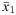
Triangular diagram classifying communities at the second level by their relationship with the walnut structure.Each community is depicted by a circle located at point (x, y) inside the equilateral triangle, which corresponds to the composition (x1, x2, and x3) of firms belonging to the IN, OUT, and GSCC components that are represented in three-dimensional space; the one-to-one correspondence between (x, y) and (x1, x2, x3) is illustrated in the associated figure (a). The size of the communities is reflected by the area of their associated circles. The triangular region is decomposed into six domains with the average composition (x¯1, x¯2, x¯3) of the IN, OUT, and GSCC components for all firms, as designated in the associated figure (b); see the text for more detailed information on the domain decomposition.